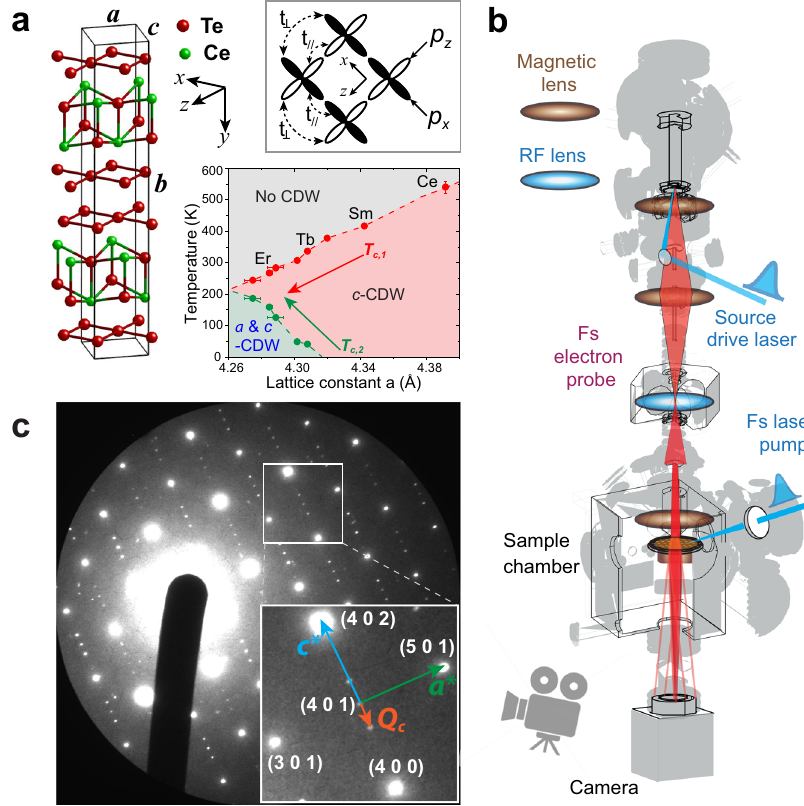
Fig. 1 Spontaneous symmetry breaking in CeTe3. a Structure of CeTe 3 . Corrugated CeTe layers are sandwiched by square Te nets, in which CDW forms. Inside box depicts the Te 5 p x and 5 p z orbital couplings near the Fermi surface in a unit cell. Inset shows the RTe 3 phase diagram with two types of SSB 14,15 . The error bar of CeTe3 is from our TEM measurement while the error bars of other compounds are from the references. b Ultrafast electron microscope column with the pump-probe setup for studying the CDW phase transitions. c Diffraction pattern of CeTe 3 obtained with the fs coherent electron beamline. Inset shows the CDW satellite peaks located at wavevector Q c away from the main lattice Bragg peaks in Miller indices. Here a * and c * are the unit cell vectors of the reciprocal